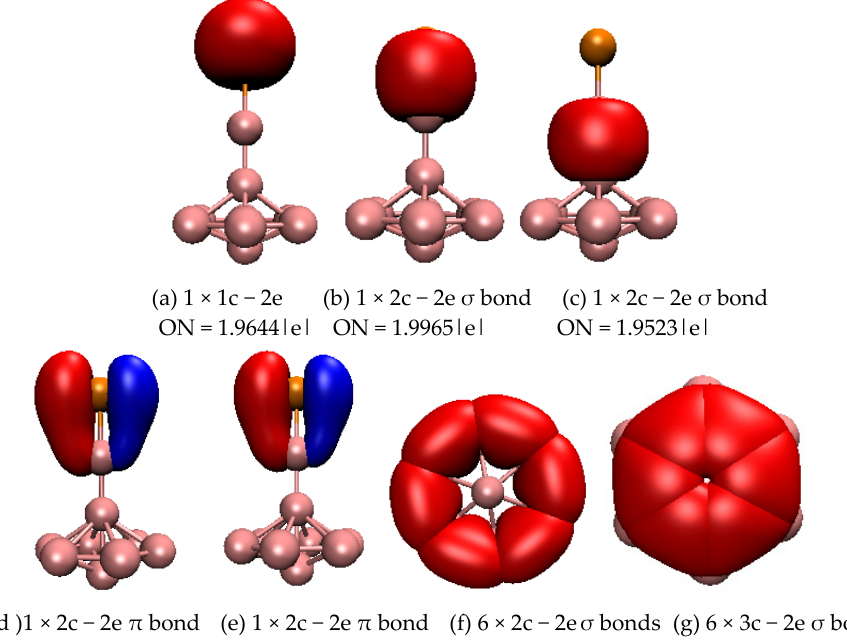
Figure 4. Bonding patterns of SeB 9 − . ON is occupation number and the orange ball is Se atom. ( a ) 1 × 1c − 2e, ON = 1.9644 |e|; ( b ) 1 × 2c − 2e σ bond, ON = 1.9965 |e|; ( c ) 1 × 2c − 2e σ bond, ON = 1.9523 |e|; ( d ) 1 × 2c − 2e π bond, ON = 1.9884 |e|; ( e ) 1 × 2c − 2e π bond, ON = 1.9884 |e|; ( f ) 6 × 2c − 2e σ bonds , ON = 1.9247 |e|; ( g ) 6 × 3c − 2e σ bonds, ON = 1.7547